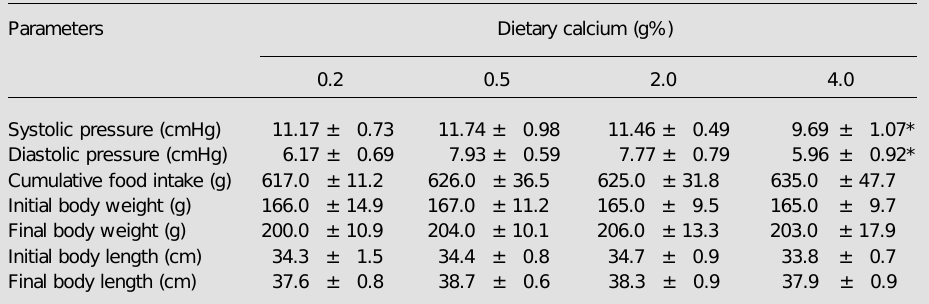
Table 1 - High dietary calcium decreases arterial blood pressure of normotensive rats fed isoproteic and isocaloric diets containing 0.2, 0.5, 2.0 and 4.0 g% calcium as calcium carbonate for 30 days ad libitum . Data are reported as means ± SEM for 8 rats in each group. *P<0.05 compared to the arterial systolic and diastolic blood pressures of the other groups (Tukey